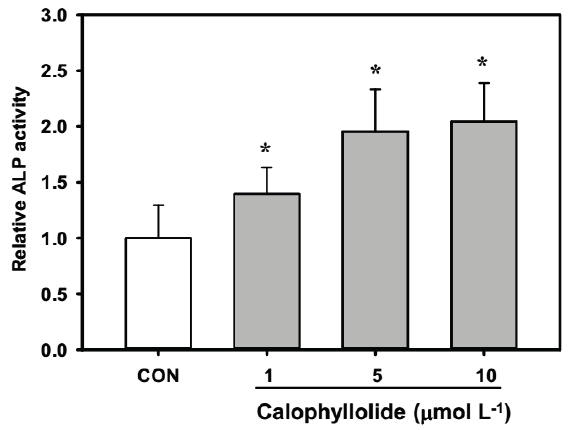
Figure 4. Alkaline phosphatase (ALP) activity of calophyllolide-treated MC3T3-E1